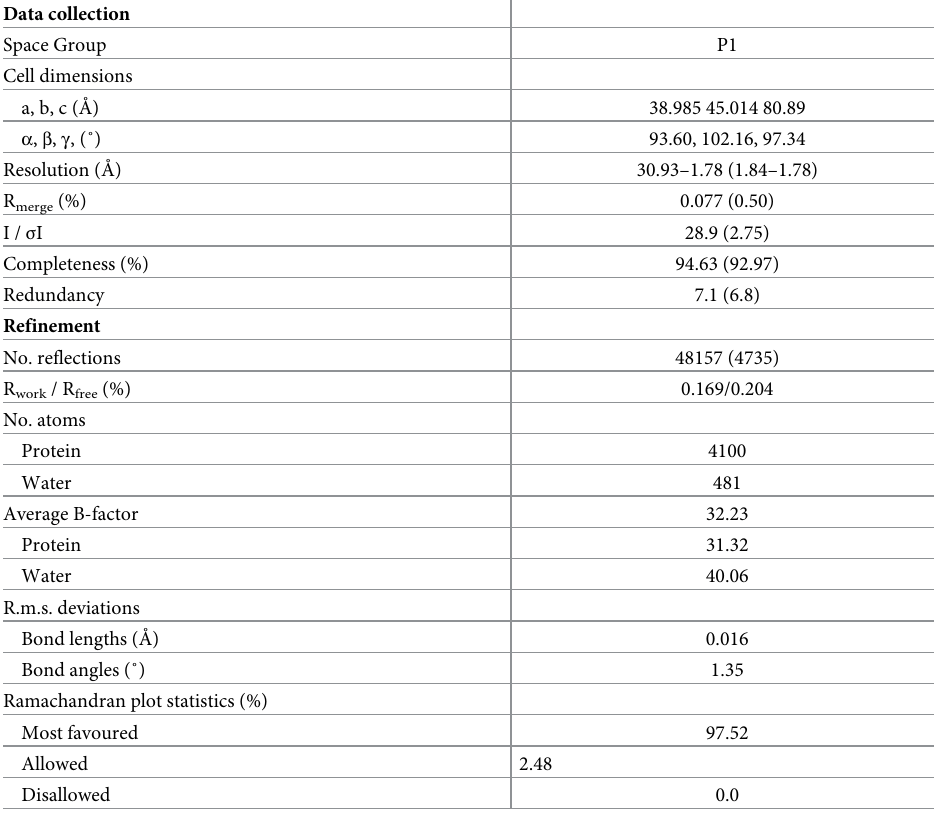
Table 2. Data collection and refinement